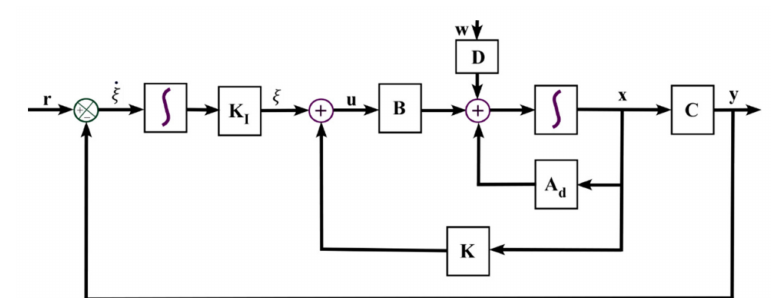
Figure 5. Block diagram of the control